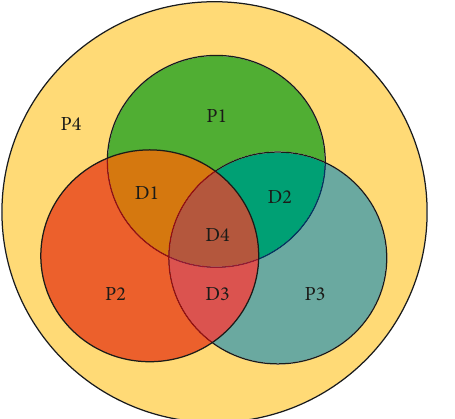
Figure 7: Parity relationship to data, extended Hamming (8,